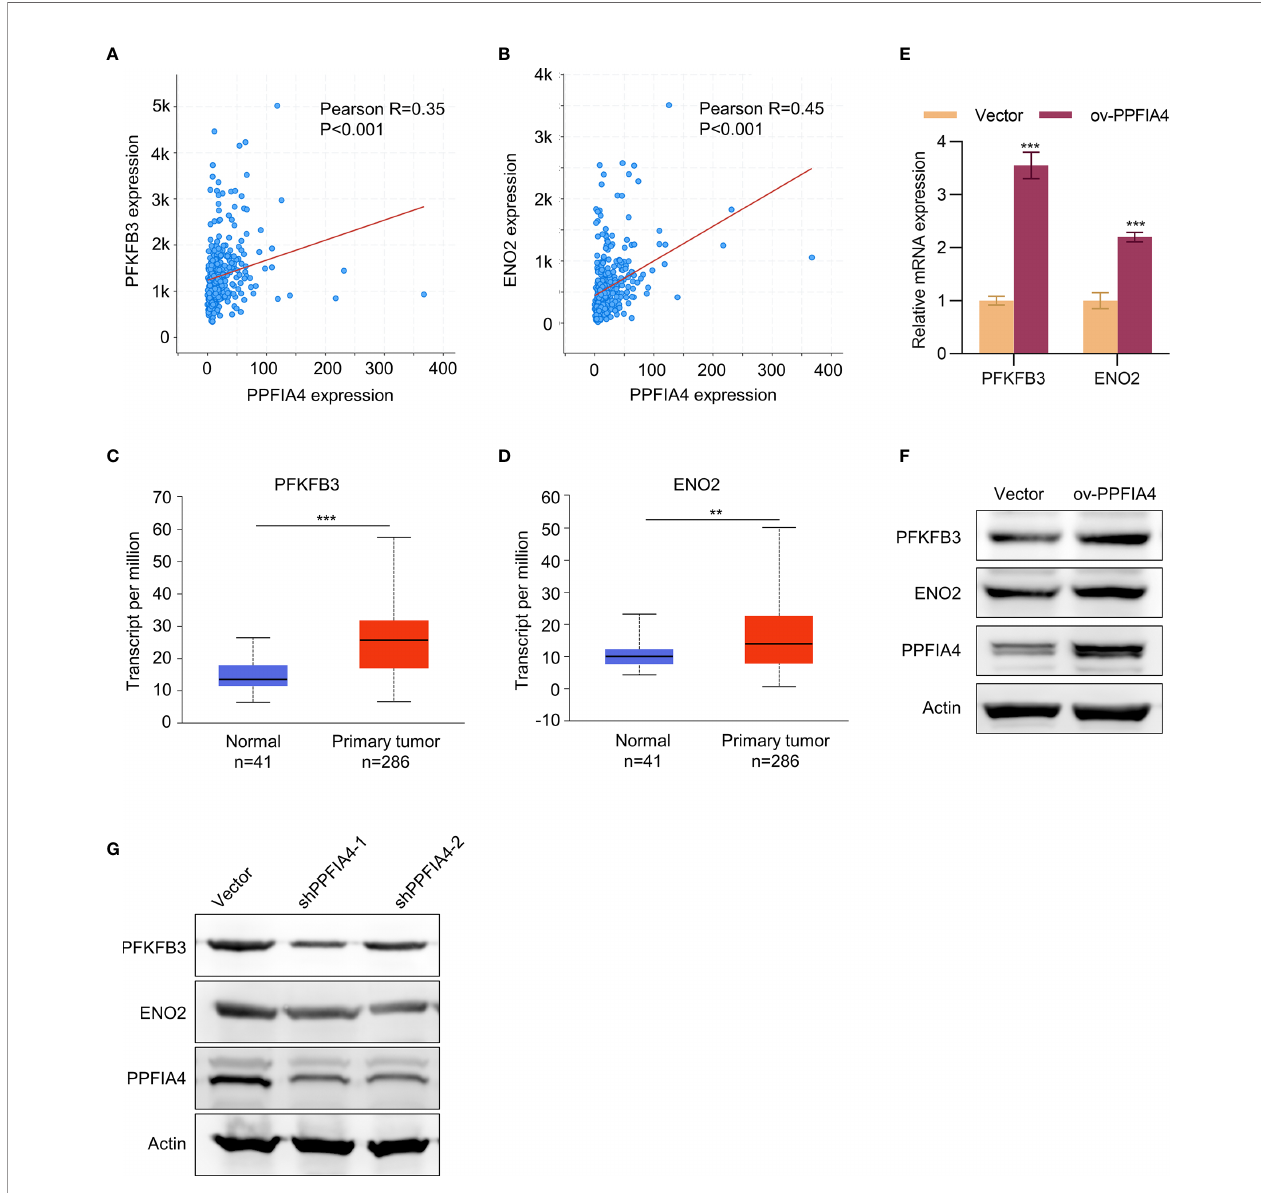
FIGURE 5 | The expression of PFKFB3/ENO2 was regulated by PPFIA4. (A) The correlation between PPFIA4 and PFKFB3 was analyzed in TCGA colorectal adenocarcinoma dataset. (B) The correlation between PPFIA4 and ENO2 was analyzed in TCGA colorectal adenocarcinoma dataset. (C) Expression of PFKFB3 in normal and colon adenocarcinoma tissues in TCGA datasets. (D) Expression of ENO2 in normal and colon adenocarcinoma tissues in TCGA datasets. (E, F) The mRNA (E) and protein (F) expression of PFKFB3/ENO2 in SW403 or SW403-PPFIA4. (G) The protein levels of PFKFB3/ENO2 in HCT116 cells transfected with PPFIA4 shRNA. **p < 0.01, ***p <